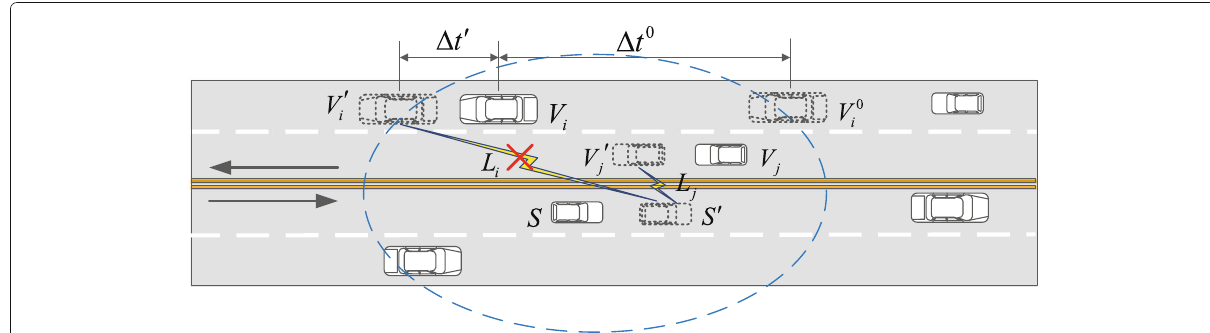
Fig. 6 Pieces-based file transfer model. S selects another vehicle ( V j ) to transfer pieces once the predicted amount of pieces have been transferred to the current vehicle ( V i )